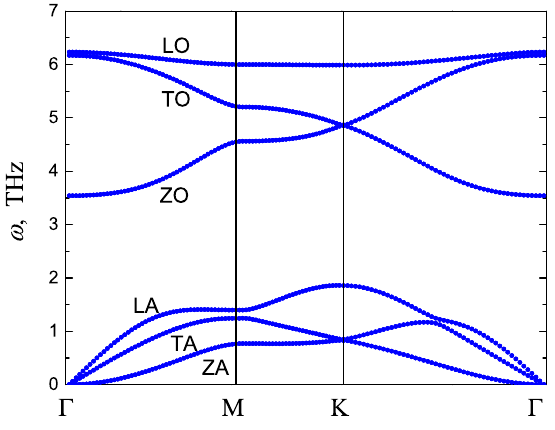
Figure 3. Phonon dispersion curves of unstrained